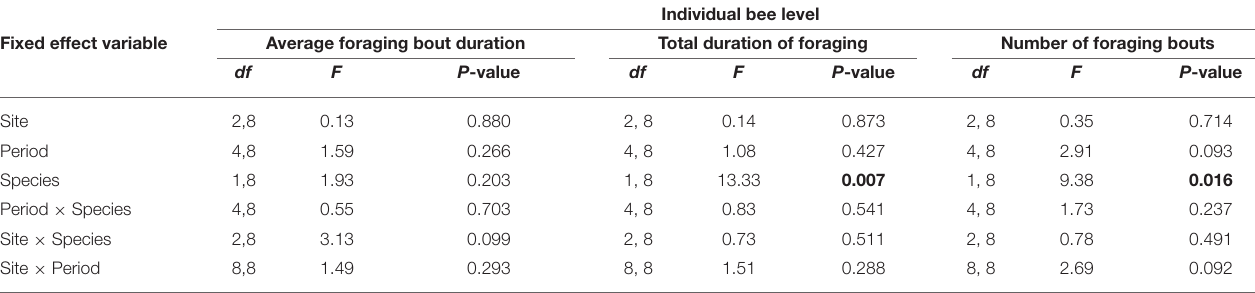
TABLE 5 | The impact of site, time period, bee species and their two-way interactions on different metrics of bee foraging effort at the individual bee level.